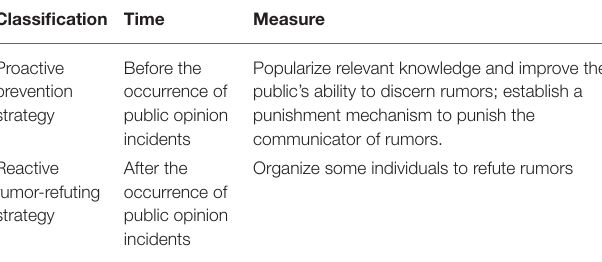
TABLE 3 | Rumor control strategy